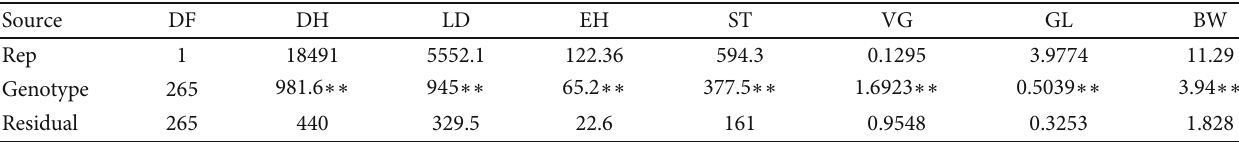
Table 3: Mean squares for Busseola fusca damage and morphological traits at the Embu site.